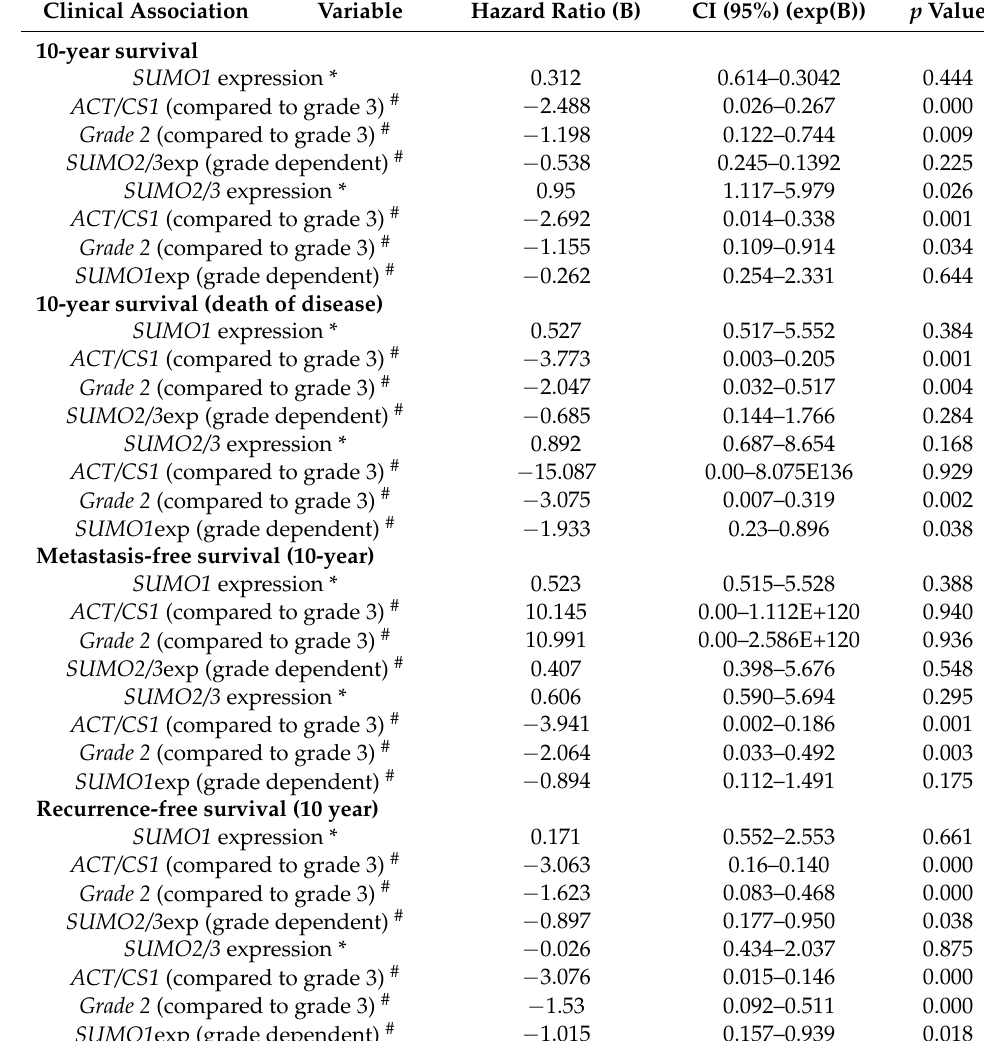
Table 1. Univariate* and multivariate # Cox regression analysis results of variates influencing